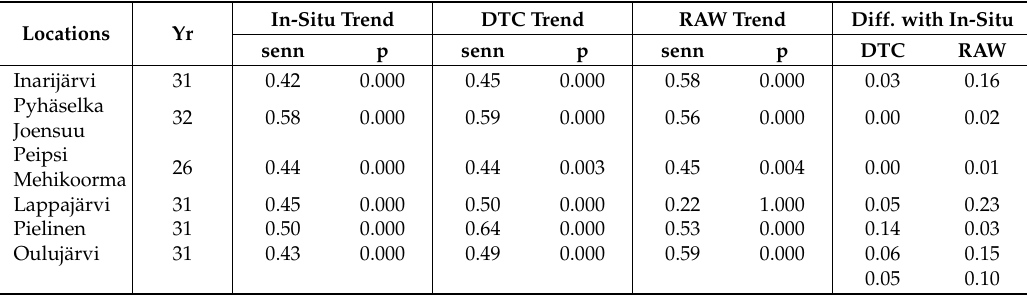
Table 6. Comparison of trends from satellite-derived LSWT with trends from in-situ data records. Only in-situ stations with data covering at least 25 years were used. The difference between DTC-adjusted trends and in-situ trends, as well as the difference between raw LSWT trends and in-situ trends, is shown in the last two